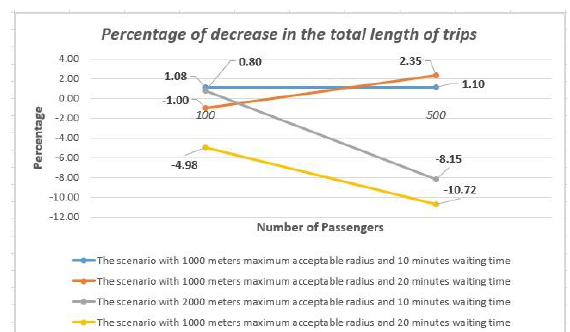
Figure 6. Percentage of decrease in the total length of